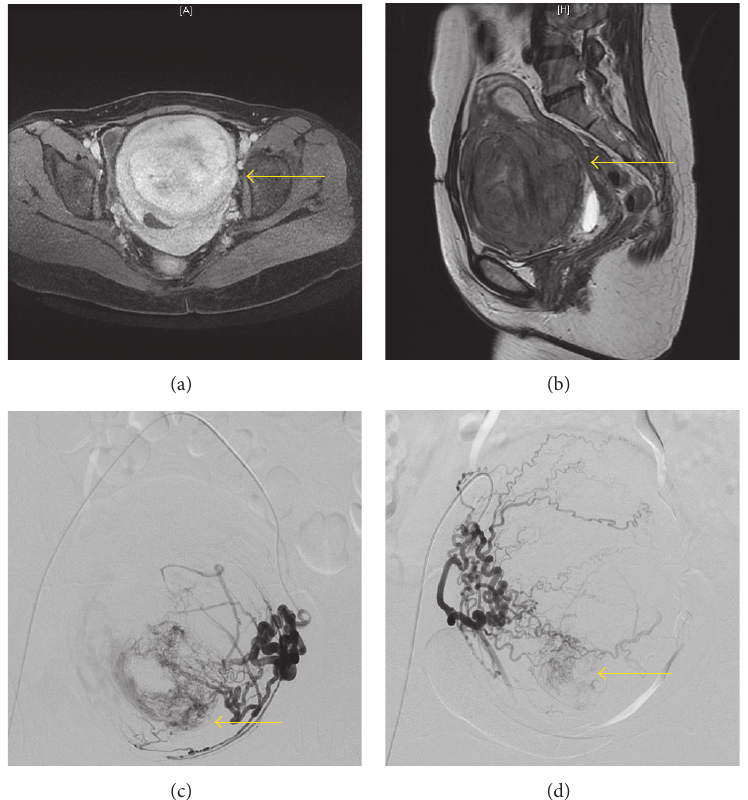
Figure 3: (a) Obvious and homogenous enhancement of the hysteromyoma and gestational sac after Gd-DTPA administration on axial T1- weighted imaging (arrow). (b) Giant hysteromyoma (9.9 cm × 9.5 cm × 9.8 cm) showing almost equal signal intensity on sagittal T2-weighted imaging (arrow). (c, d) Selective bilateral uterine arteries DSA showing persistence of the prominently enlarged and tangled vessels in the uterine and gestational sac measuring about 2.5 cm × 2 cm